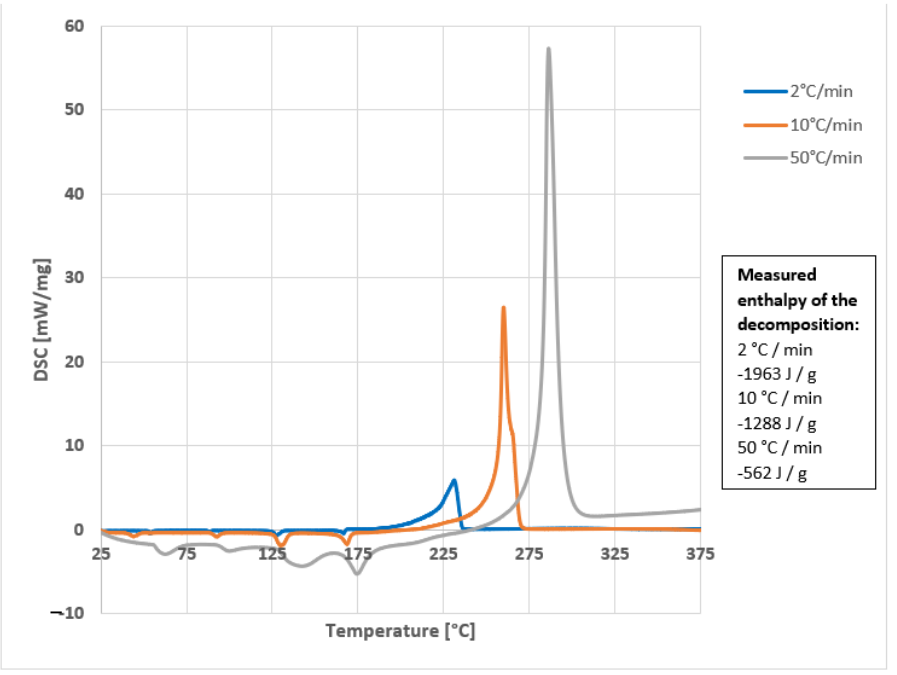
Figure 7. DSC analysis of AN and PE mixture (containing 20% of the polymer) and thermal effect of the decomposition reaction for different heat rates.